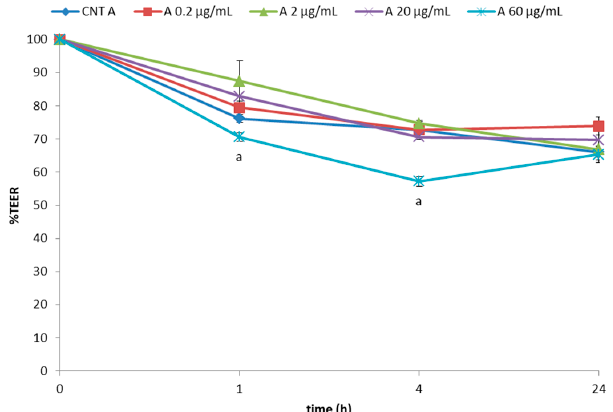
Figure 3. Effects of in vitro digested tomatine (A) on Caco-2 TEER values expressed as % relative to the control (AC). Values represent mean ± standard deviation of three different biological replications and two technical repetitions. Different superscript letters indicate statistically significant differences ( p < 0.05) in adhesion as assessed by one-way ANOVA test.